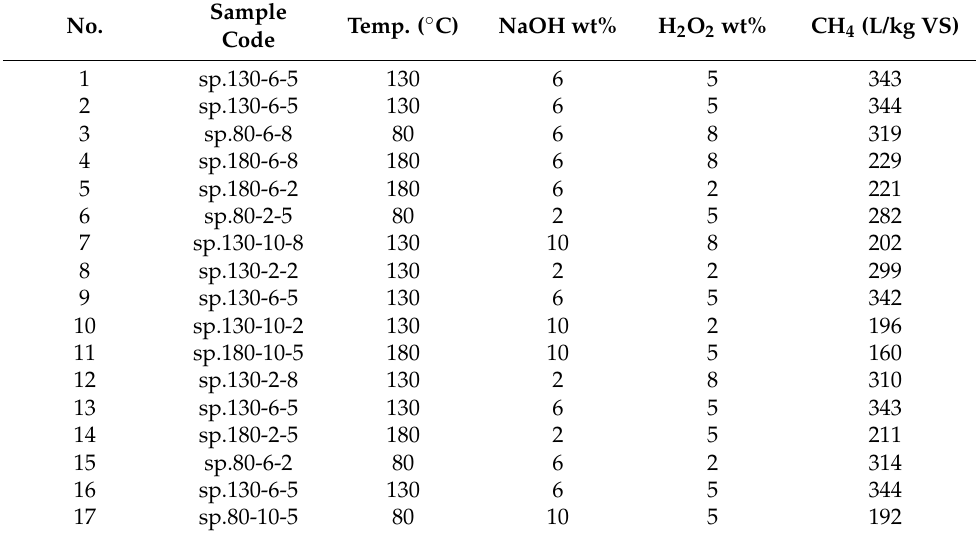
Table 3. BBD matrix and